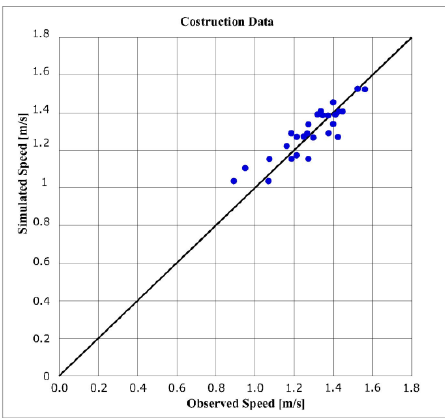
Figure 2. Global model. Comparison between observed and simulated speeds.